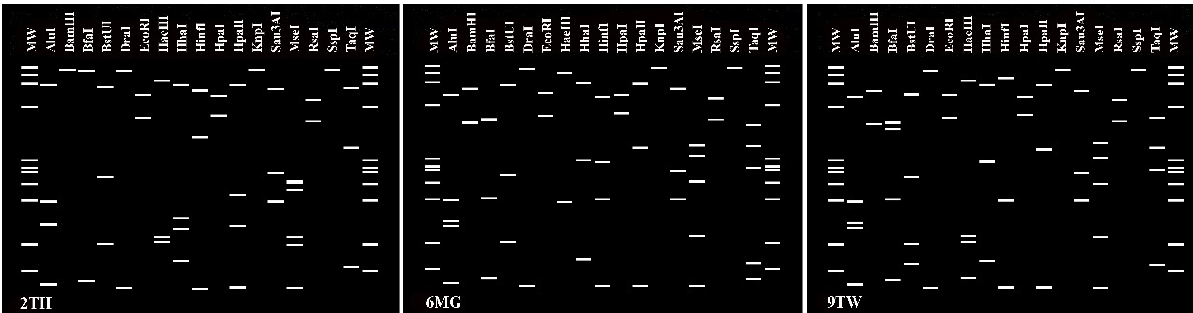
Figure 3. Distinct virtual RFLP patterns from in silico digestion of 16Sr gene F2nR2 fragments of the 3 sequences that may represent new 16Sr phytoplasma groups. From left, samples 2TH, 6MG, 9TW. Recognition sites for the following 17 restriction enzymes were used in the simulated digestions: AluI , BamHI , BfaI , BstUI ( ThaI ), DraI , EcoRI , HaeIII , HhaI , HinfI , HpaI, HpaII , KpnI, Sau3AI ( MboI), MseI , RsaI , SspI and TaqI . MW, φ X174 DNA- HaeIII digestion as a marker.